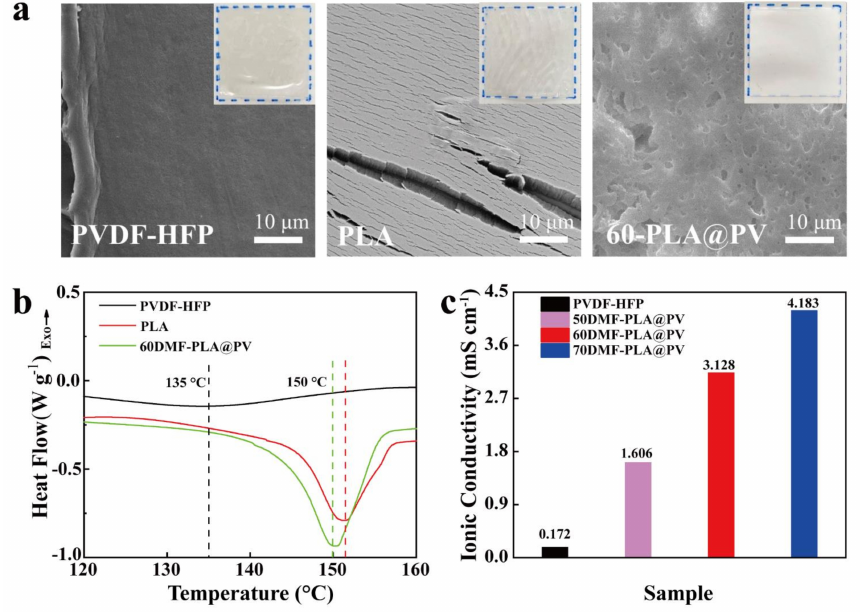
Figure 4. Characterization of physical and chemical properties of composite membranes: ( a ) Digital images and SEM morphologies of the three membranes after thermal treatment. ( b ) DSC thermograms of PLA, PVDF-HFP and the porous 60-PLA@PV. ( c ) Ionic conductivities of different